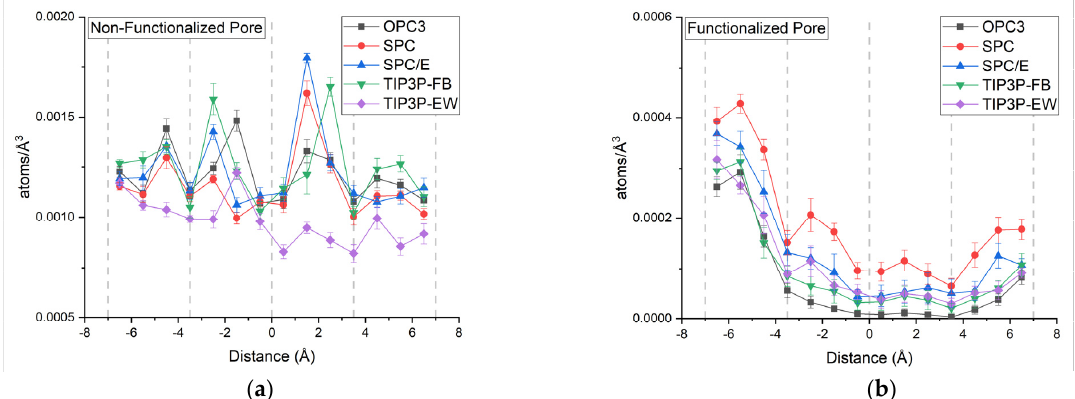
Figure 7. Number density of water molecules inside ( a ) non − functionalized and ( b ) functionalized pore (grey dashed lines represent the initial location of graphene layers).